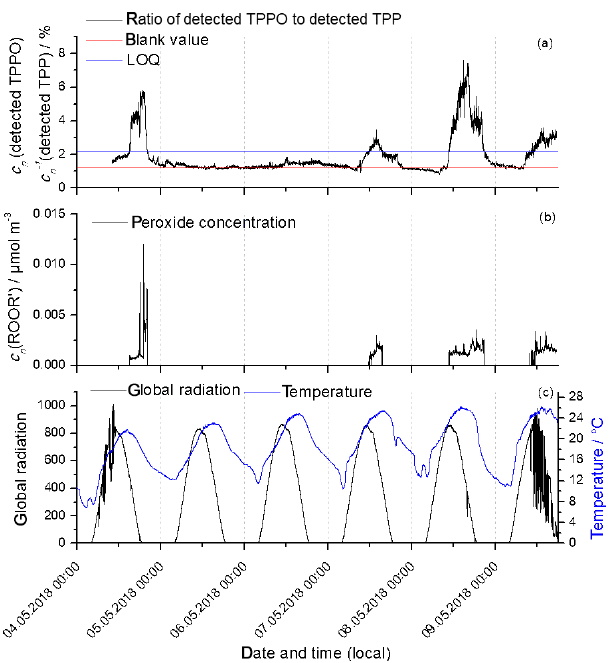
Figure 8. (a) Time series of the relative amount of detected TPPO to detected TPP, LOQ, and blank value, (b) diurnal variation in the estimated peroxide concentration, and (c) time series of the global radiation and